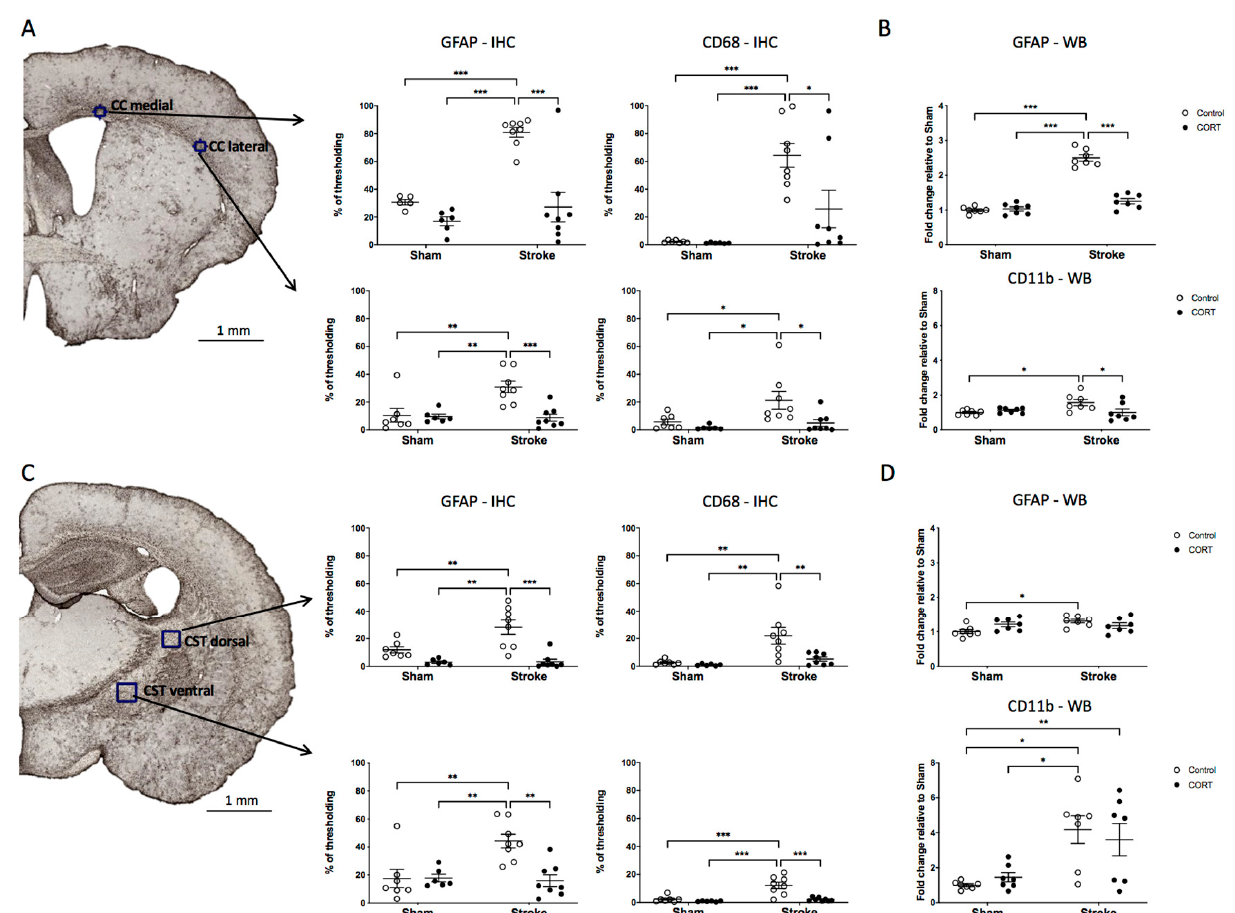
Figure 4. Astrogliosis and microgliosis in the corpus callosum (CC) and corticospinal tract (CST). The left side of Panel ( A ) shows representative glial fibrillary acidic protein (GFAP) immunohistochemistry of the CC. The graphs on the right side show changes in the percentage of thresholding for GFAP and cluster of differentiation 68 (CD68) for two regions of the CC (black boxes). ( B ) Western blot quantification of GFAP (upper graphs) and cluster of differentiation 11b (CD11b) (lower graph). The left side of panel ( C ) shows representative GFAP immunohistochemistry of the CST. Graphs on the right show changes in percentage of thresholding for GFAP and CD68 for 2 regions of CST (black boxes). ( D ) Western blot quantification of GFAP (upper panel) and CD11b (lower panel). Data on graphs are expressed as mean ± SEM *** p < 0.001, ** p < 0.01, * p < 0.05.